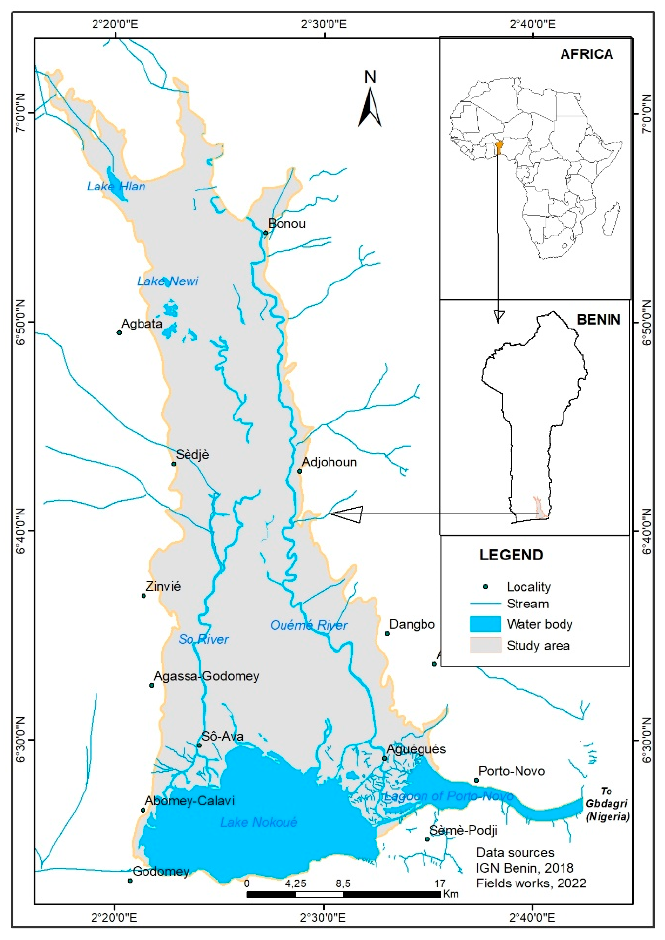
Figure 1. Geographical location of the Ouémé Delta.